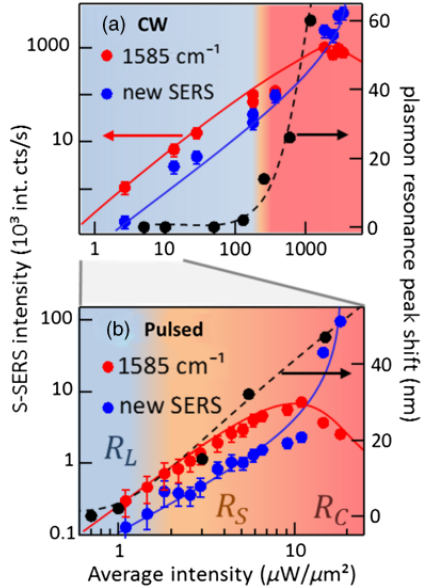
FIG. 4. Driven photochemical bond breaking. (a) – (b) Stokes- SERS intensities (left axis) for persistent sharp 1585 cm − 1 mode (red points) and new SERS peaks (integrated, blue points) from a single NPoM for increasing average laser intensity I , with (a) CW and (b) pulsed excitation. The right axis (black points) shows the corresponding shifts of the coupled plasmon mode in simulta- neous dark-field scattering spectra. Lines are guides for the